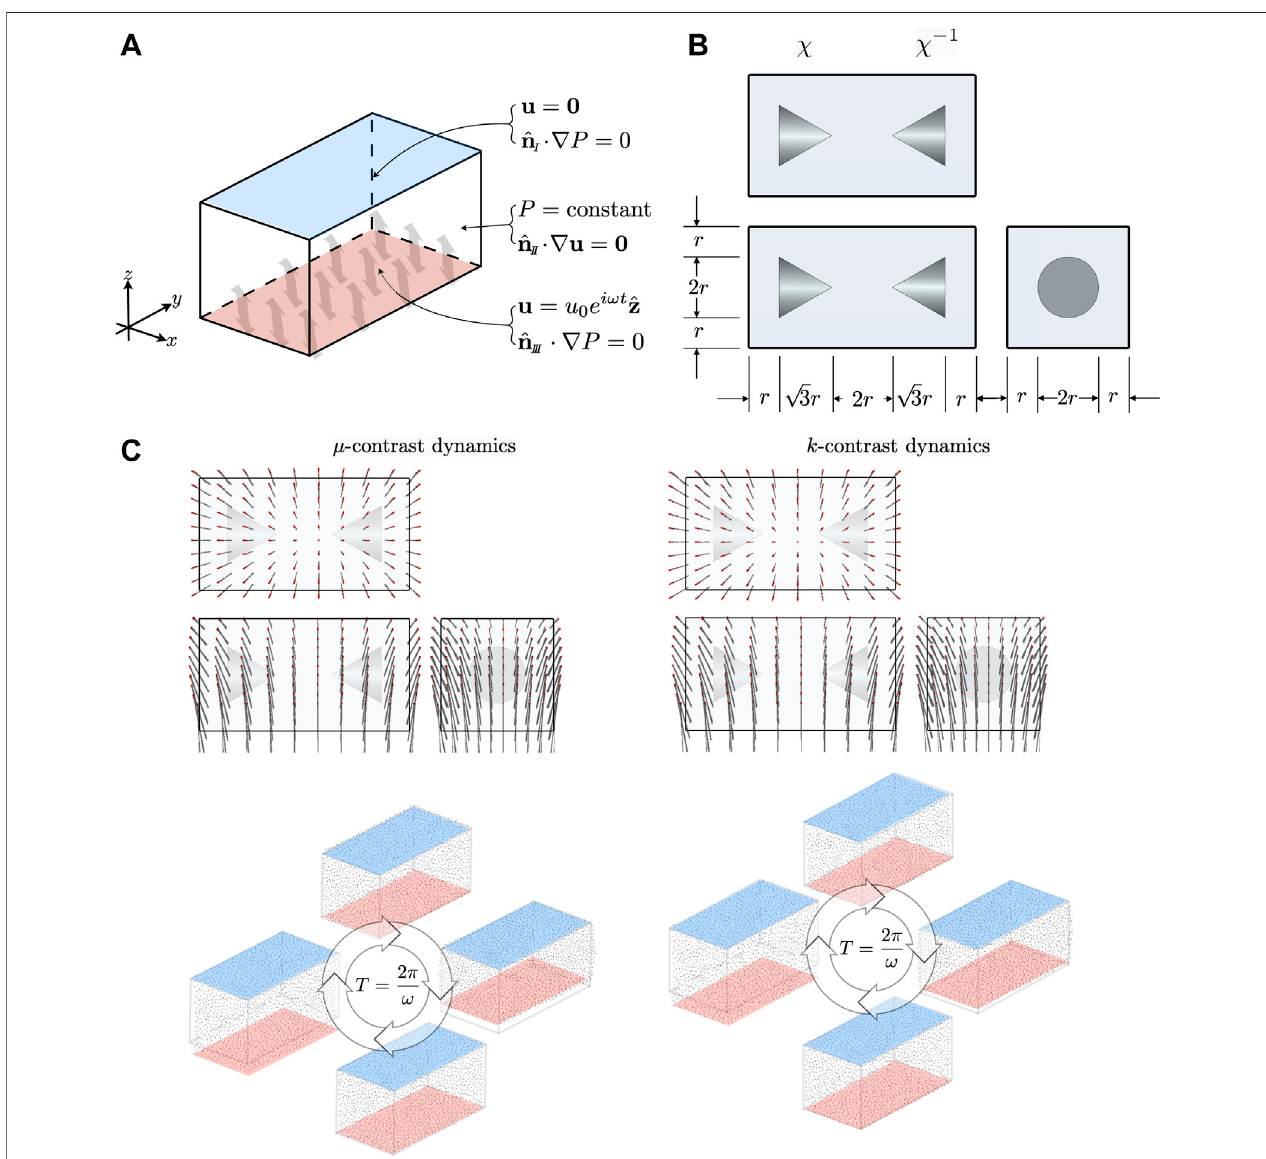
MRE f displacement fi eld over one period is shown for both, the red dots representing in-phase displacements at the start of a cycle. Below these, the motion of the boundary nodes is displayed at four equally spaced times within the cycle of period T